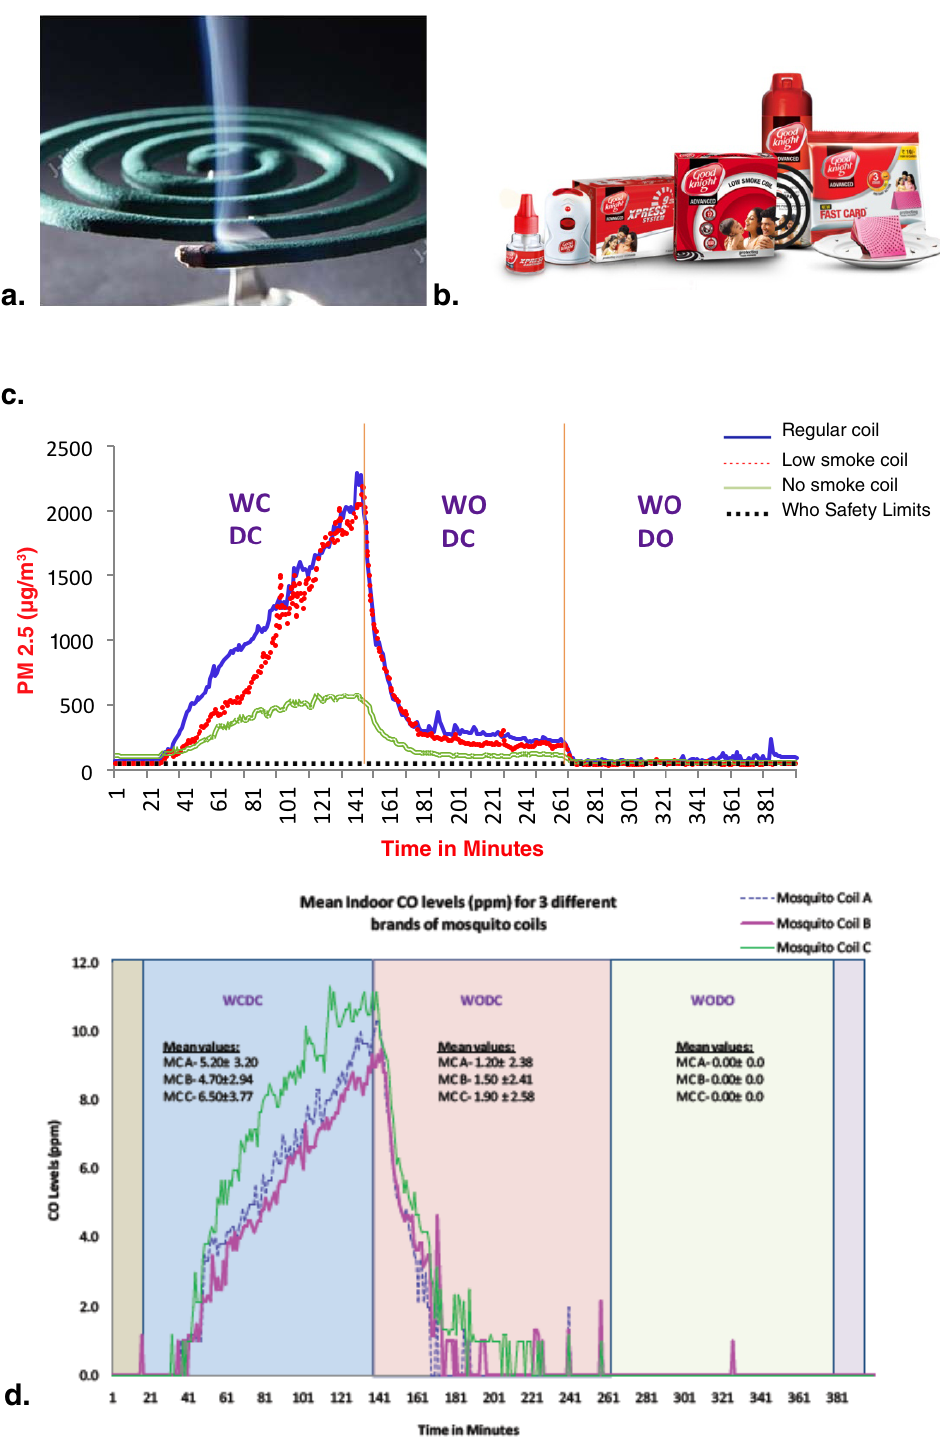
Figure 3. Mosquito repellents and the pollutant emission levels. a. Burning mosquito coil b. Range of mosquito repellents manufactured by Goodnight© c. PM levels when burning three different brands of mosquito coils with different modes of ventilation d. CO levels when burning three different brands of mosquito coils with different modes of ventilation. CO, carbon monoxide; DC, door closed; DO, door open; PM , particulate matter of less than 2.5 microns in mean aerodynamic diameter; WC, window closed; WHO, World Health Organization; WO, window